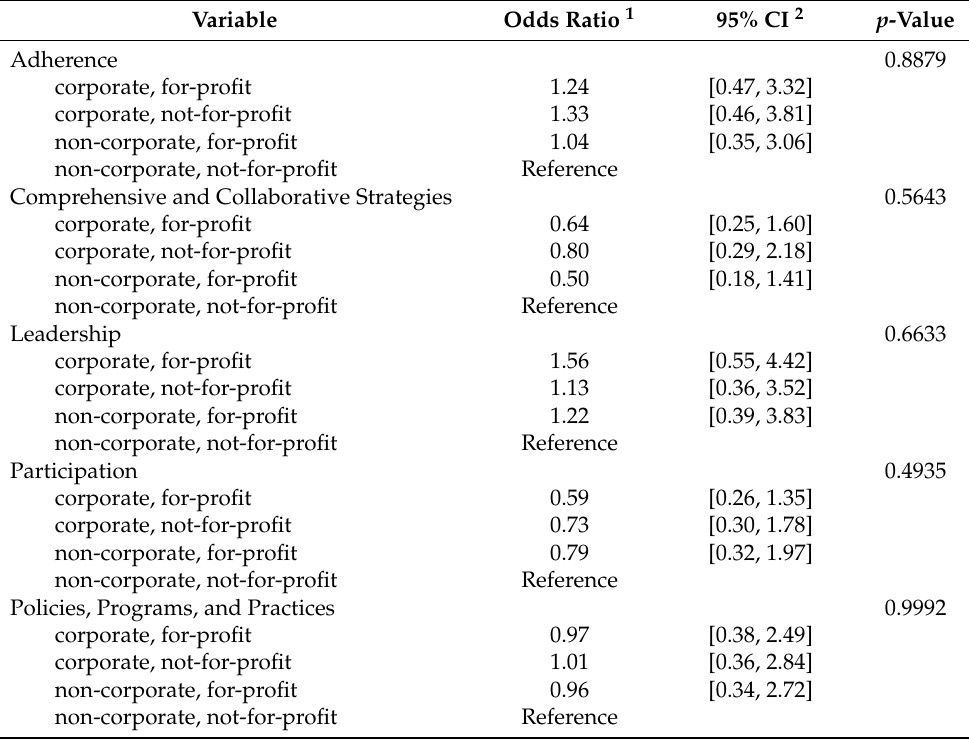
Table 5. Association between corporate nursing home ownership and being in the bottom 25% percentile of WISH